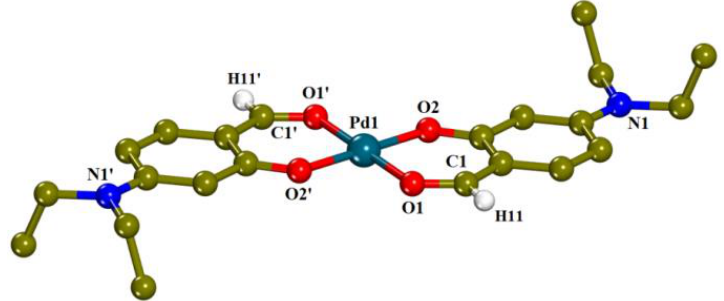
Figure 2. Crystal structure of complex 1 . Aromatic and ethyl hydrogen atoms and solvate molecules are omitted for clarity. Selected bond distances and angles: Pd1 — O1 = 1.987(2) Å , Pd — O2= 1.985(2) Å ; O1 — Pd1 — O2 = 94.83(9)°, O 1′— Pd1 —O2 = 85.17(9)°. (Symmetry code: (’) − x + 1 , − y + 1 , − z + 1).